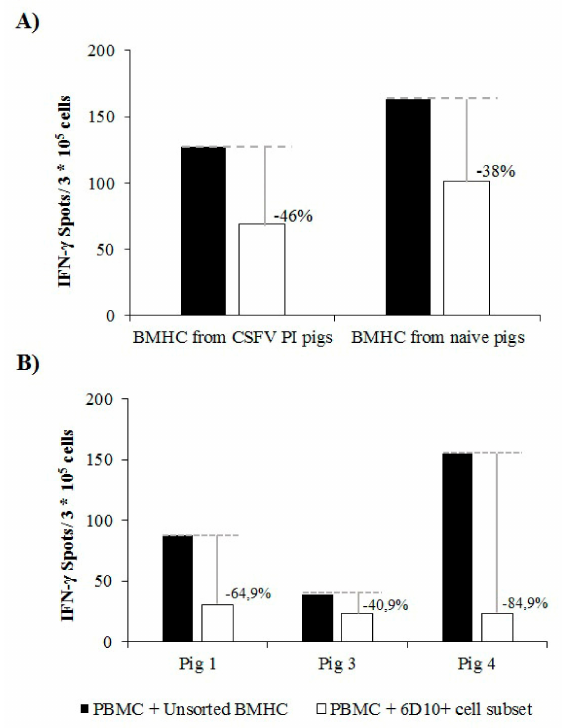
Figure 5. Reduction of the IFN- γ response by the granulocytic cell subset from BMHC. ( A ) PBMCs from a naïve animal were co-cultured with unsorted or 6D10 + cells from the BMHC of naïve or CSFV persistently infected pigs in a 1:3 ratio and stimulated with phytohaemagglutinin (PHA). ( B ) PBMCs from a CSFV-specific immune animal were co-cultured with unsorted or 6D10 + cells from BMHC of naïve or CSFV persistently infected pigs in a 1:3 ratio and stimulated with CSFV Cat01 (MOI = 0.1). The x axis indicates the origin of the BMHCs used for co-culture. IFN- γ production was measured by ELISPOT assay. All the assays were performed by triplicate to corroborate the